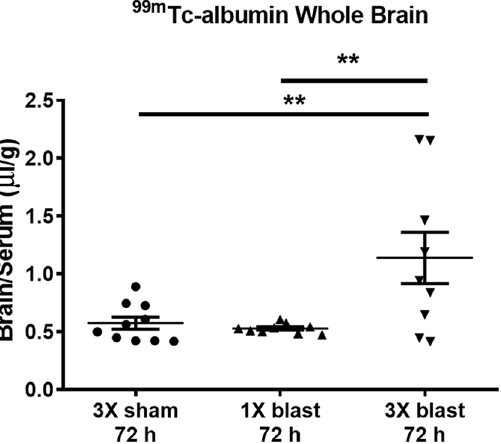
Figure 2. Repetitive blast exposure increases BBB permeability to radiolabeled albumin. A significant increase ( ** p ≤ 0.01) in brain/serum (u μ l/g) ratios of 99m Tc-albumin was observed in whole brain at 72 h after repetitive mTBI (3X blast; n = 12) compared to 1X blast ( n = 12), and sham control mice ( n = 12). One-way ANOVA post-hoc Newman-Keuls. Values represent means ± SEM and are expressed as microliters per gram of brain tissue. Brain/serum ratios were calculated by dividing the cpm per brain by the cpm per microliter in the corresponding serum and then by the weight of the brain.